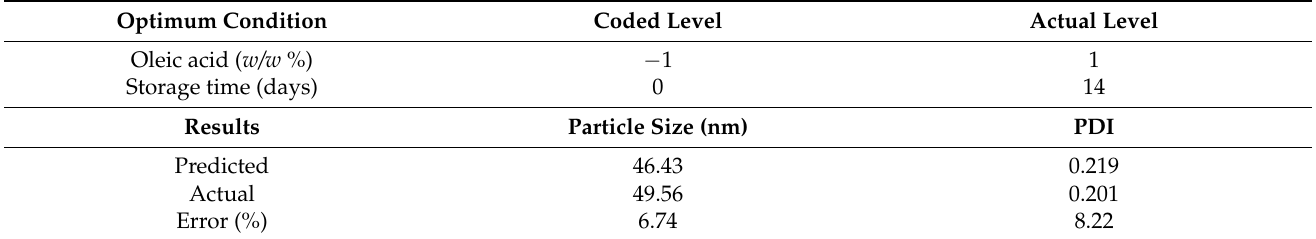
Table 5. Experimental